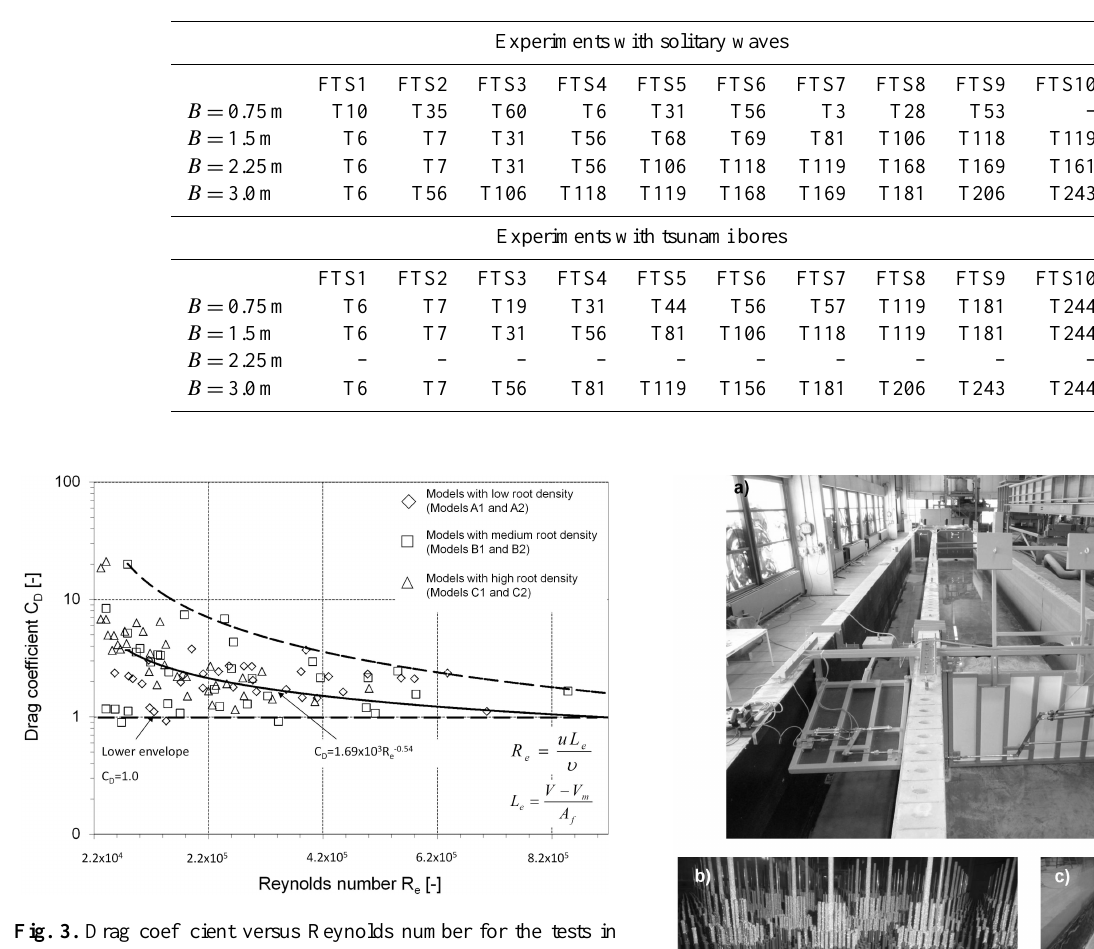
Table 3. Locations of force transducers measuring forces exerted on single mangrove models (FTS1–FTS10) within forest models of different widths (symbols T6–T244 denote the number of the parameterized mangrove model, to which the force transducer was connected – see also Fig. 6).